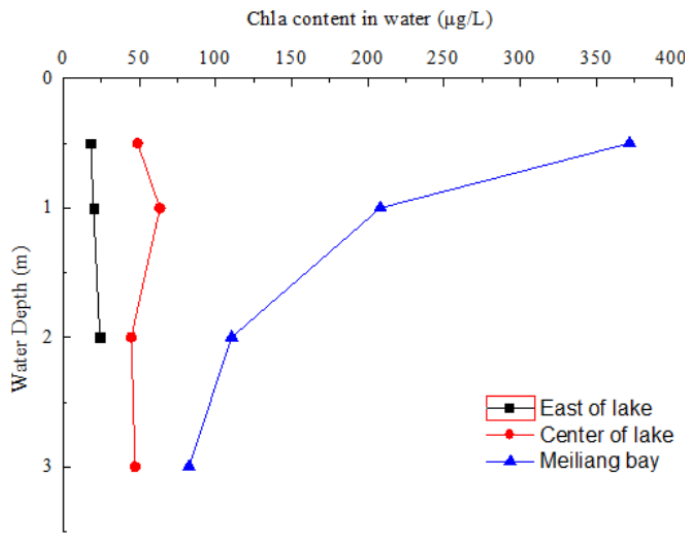
Figure 2. Chla contents in different water depths of Taihu Lake.